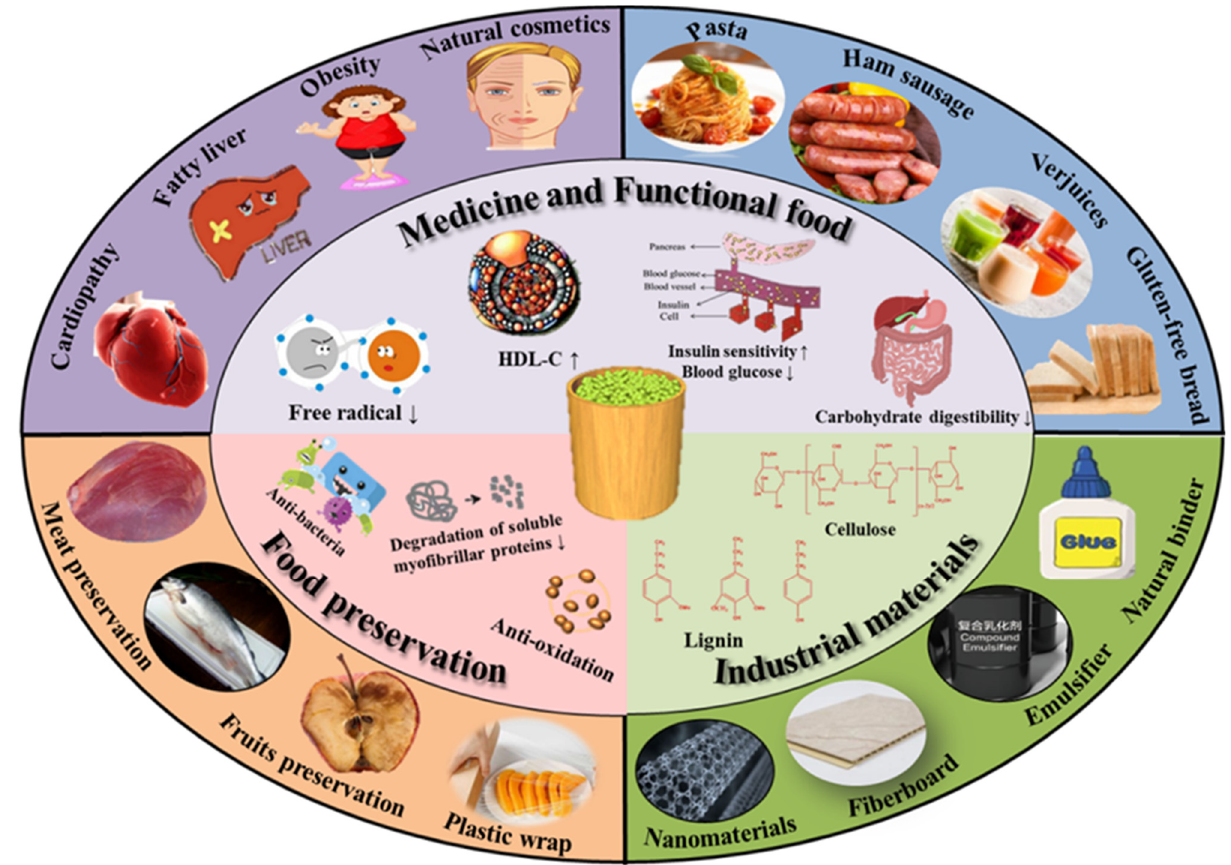
Figure 3. High added value of thinned unripe fruits (possible applications of unripe fruits in medicine, functional food, food preservation, and industrial materials).